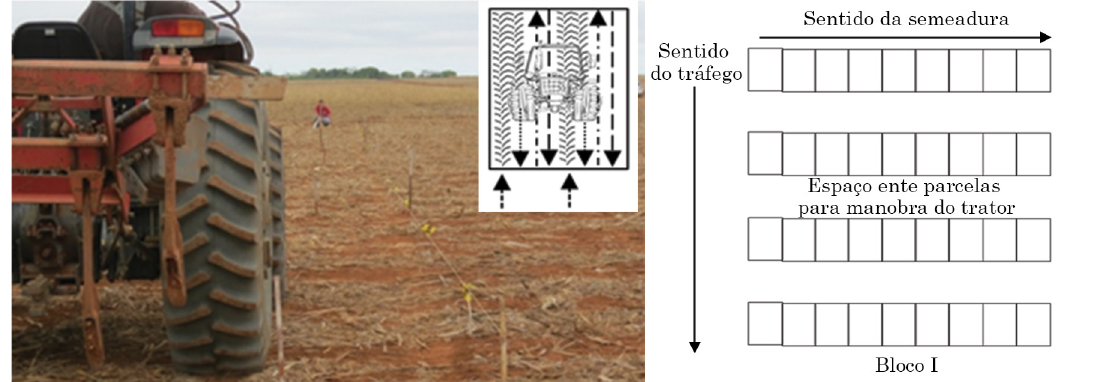
Figura 2. Croqui de um bloco da área experimental ilustrando, em detalhe, o tráfego do